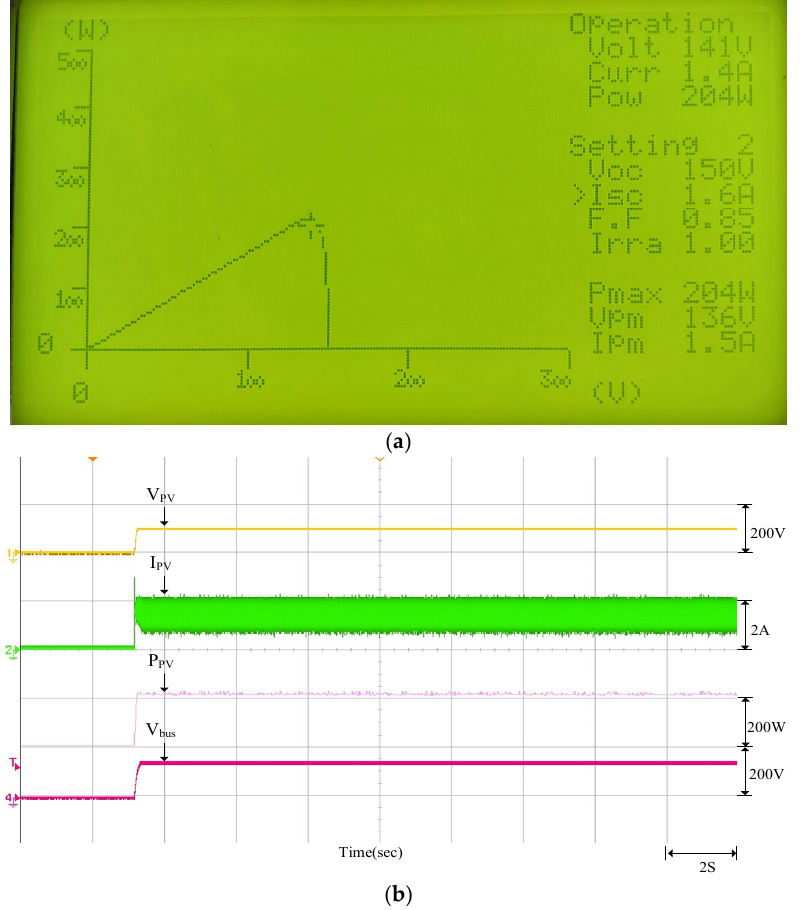
Figure 13. Under maximum power tracking when the photovoltaic module outputs 200 W: ( a ) P–V characteristic curve diagram; ( b ) actual tested waveform.